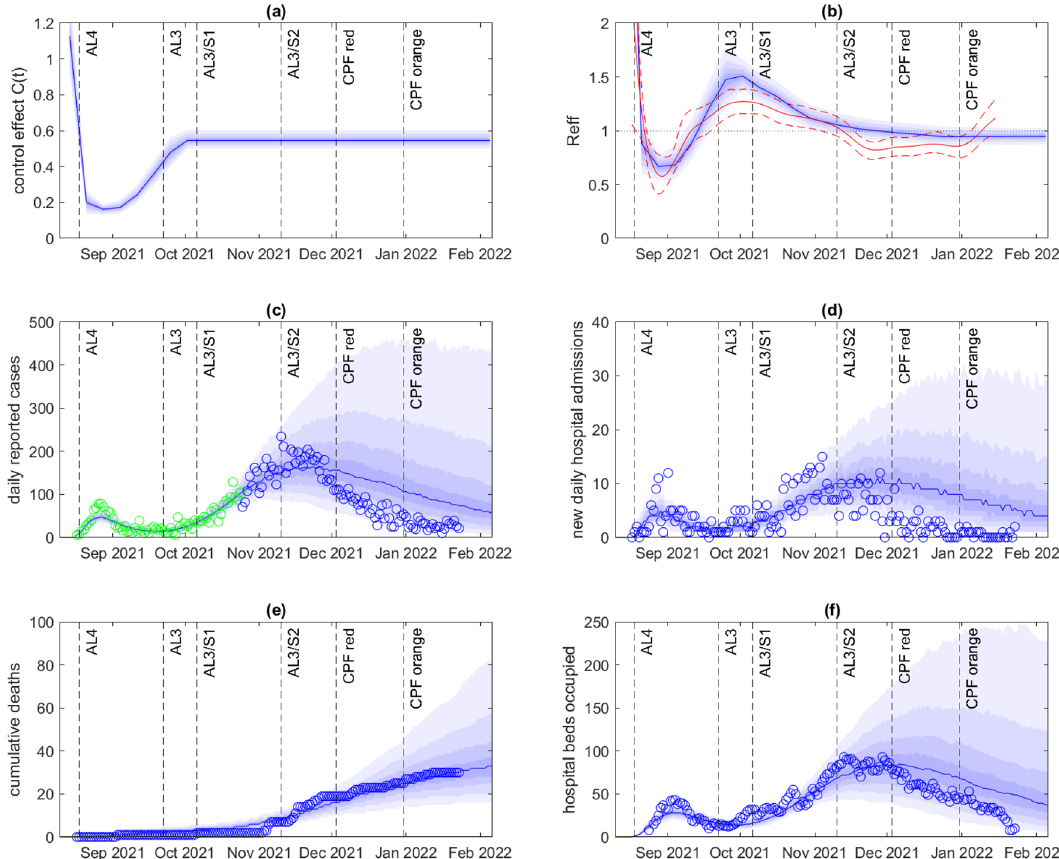
Figure 5. Model results fitted to data up to 24 October 2021. ( a ) Inferred control function C ( t ) ; ( b ) Effective reproduction number R eff ( t ) calculated in the model (blue) based on time-varying control function C ( t ) , and vaccine-derived and infection-derived immunity, and independently estimated using the EpiNow2 package 23,45 (median estimate red solid, 90% credible band red dashed); ( c ) Daily reported cases; ( d ) New daily hospital admission; ( e ) Cumulative deaths; ( f ) Hospital beds occupied. In ( c ), green points show data that was used to fit the control function shown in ( a ). In (a,b), the blue curve shows the median and the shaded blue bands show the 10th, 20th, 30th, 40th, 60th, 70th, 80th, and 90th percentiles of the estimated posterior distribution for C ( t ) . In ( c – f ), the blue curve shows the median and the shaded blue bands show the 10th, 20th, 30th, 40th, 60th, 70th, 80th, and 90th percentiles of the specified model output across the best-fitting n = 500 out of 2500 model simulations, each with C ( t ) sampled independently from the estimated posterior. Dashed vertical lines show the times of key changes to public health restrictions for the Auckland region (see Table